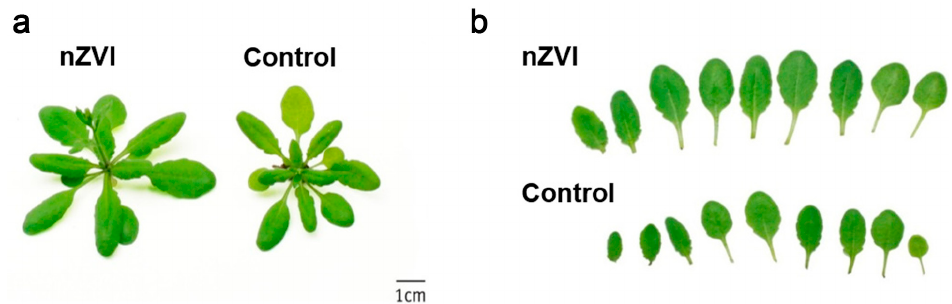
Figure 9. Phenotype ( a ) and photo ( b ) of growth of control and nanoscale zerovalent iron (nZVI)- exposed Arabidopsis shoot at 21 days. Reprinted with permission from Ref. [86]. Thus, at the physiological level, the effects of MNPs on plants are more dependent on the particles themselves, for which the plants could have corresponding countermeasures. opment by altering plant photosynthetic centers and reducing chlorophyll content, but are mostly limited to the high ion concentration range